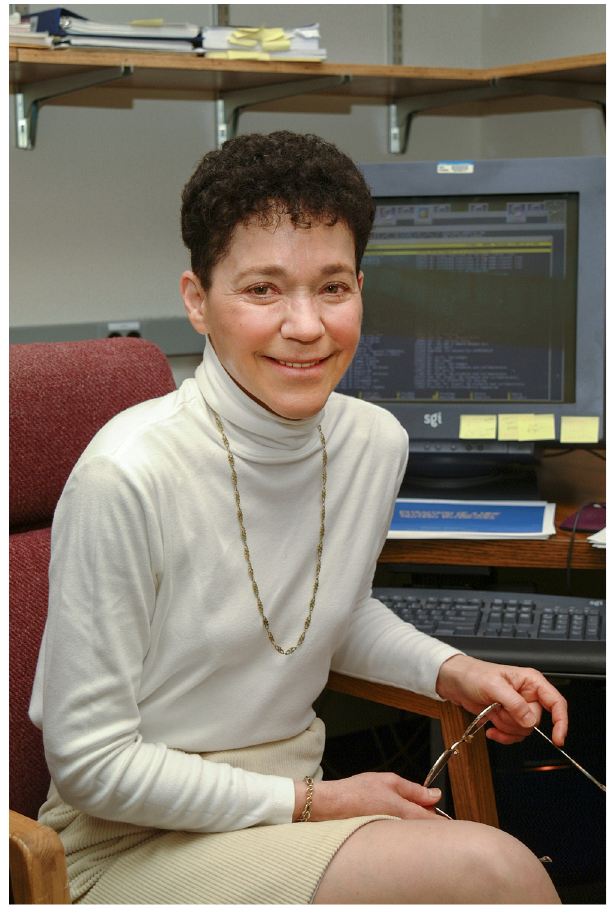
Fig 5. Ruth Nussinov. Senior investigator and head of computational structural biology group, Laboratory of Experimental Immunology, Cancer and Inflammation Program, NCI, NIH, and professor in the School of Medicine, Tel Aviv